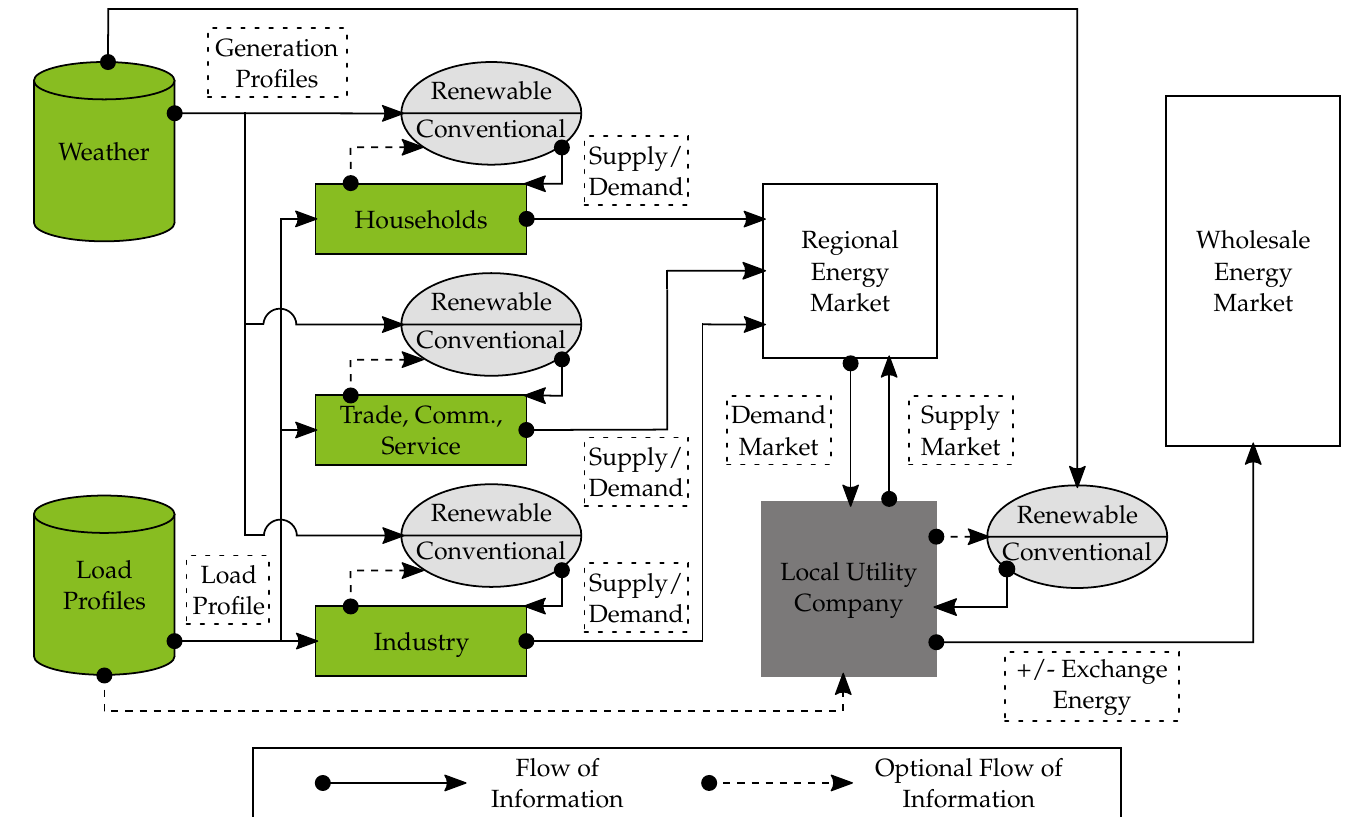
Figure 2. Overview model structure.